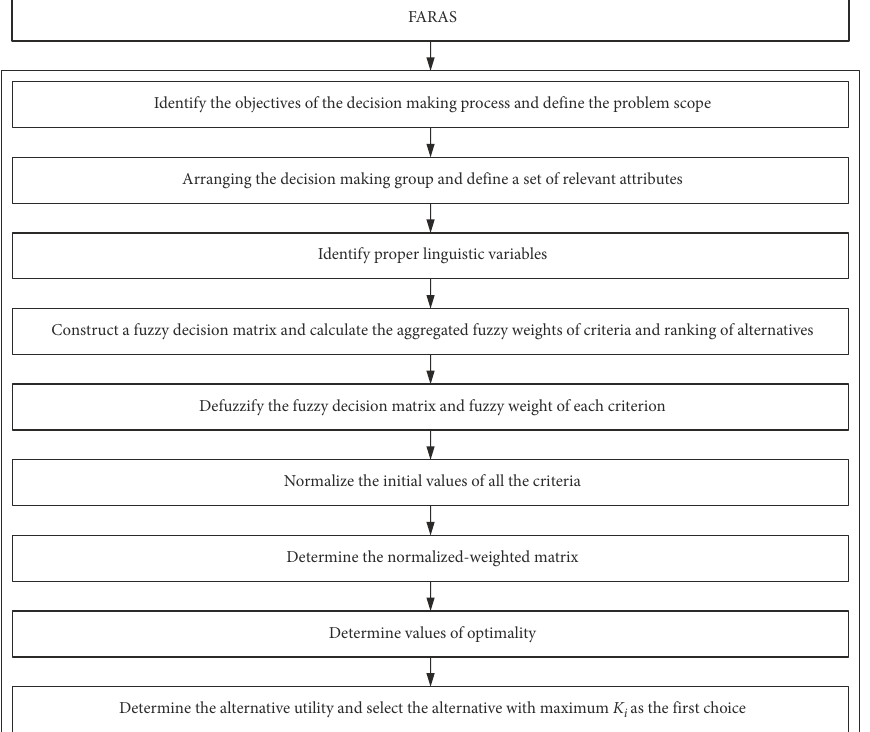
Figure 2. Schematic diagram of the proposed model